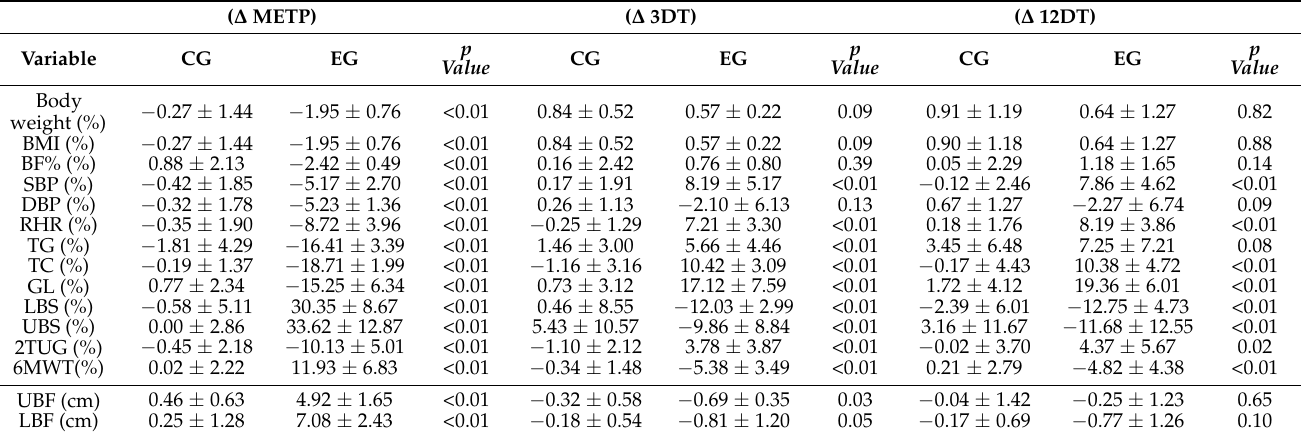
Table 2. METP and DT effects ( ∆ % mean ±